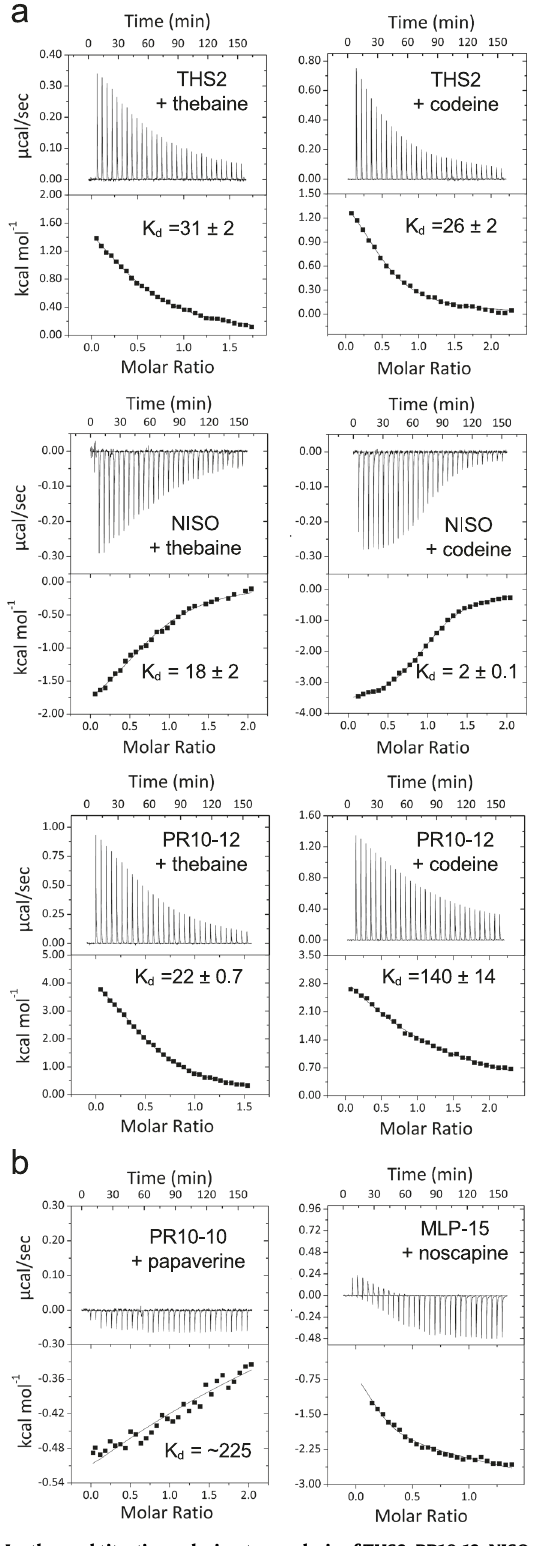
Fig. 4 |IsothermaltitrationcalorimetryanalysisofTHS2, PR10-12, NISO,PR10- 10 and MLP15. a ITC thermograms for thebaine and codeine binding to THS2, PR10-12, and NISO. K d values represent mean ± standard error. Each panel set is representative of three fully independent experiments. All experiments were per- formed in PBS buffer, pH 7.4. b ITC thermograms for noscapine binding to MLP15 andpapaverinebindingtoPR10-10.AllexperimentswereperformedinCBSbuffer. Each panel set is representative of three fully independent